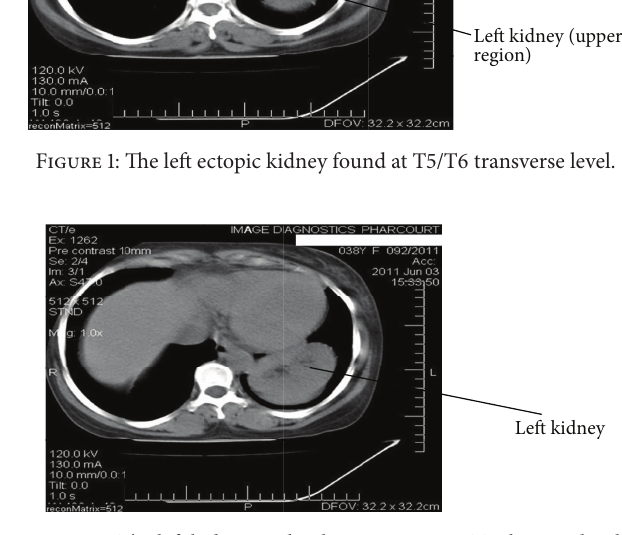
Figure 2: The left kidney in the thoracic cavity at T9 thoracic level. Notice the right kidney is yet to be